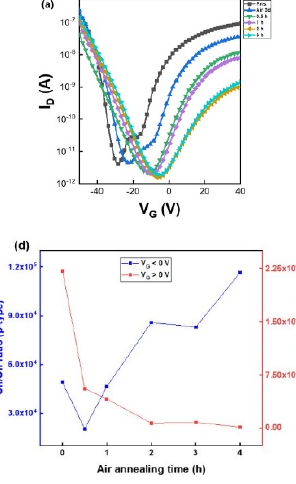
Figure 2. ( a ) Transfer curves (at V D = 1 V), ( b ) optical image, ( c ) AFM height profile (inset: AFM image), ( d ) current on/off ratios versus air annealing time, and ( e ) output curves (at V G = 0 V) of MoTe 2 FET #1.